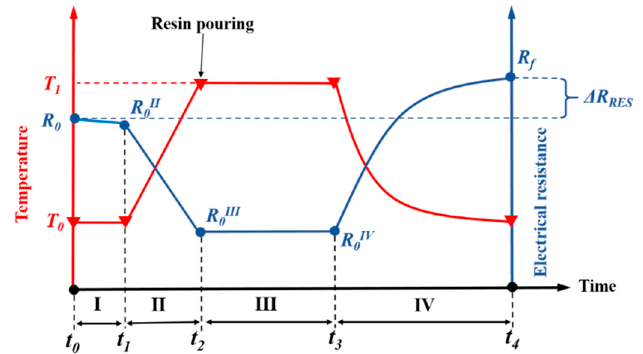
Figure 2. Curing temperature program for CNTY / ER-A and CNTY / ER-B specimens and sketched electrical resistance variation, divided into four zones.